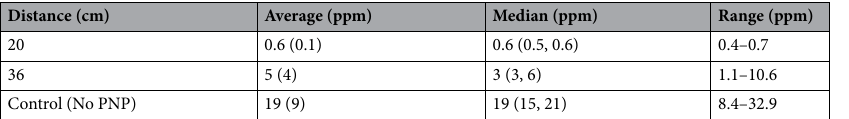
Table 1. Average and median VOC values for PNP distances of 20 and 36 cm. Averages and standard deviations are written as average (standard deviation). Medians and interquartile ranges are written as median (Q1,